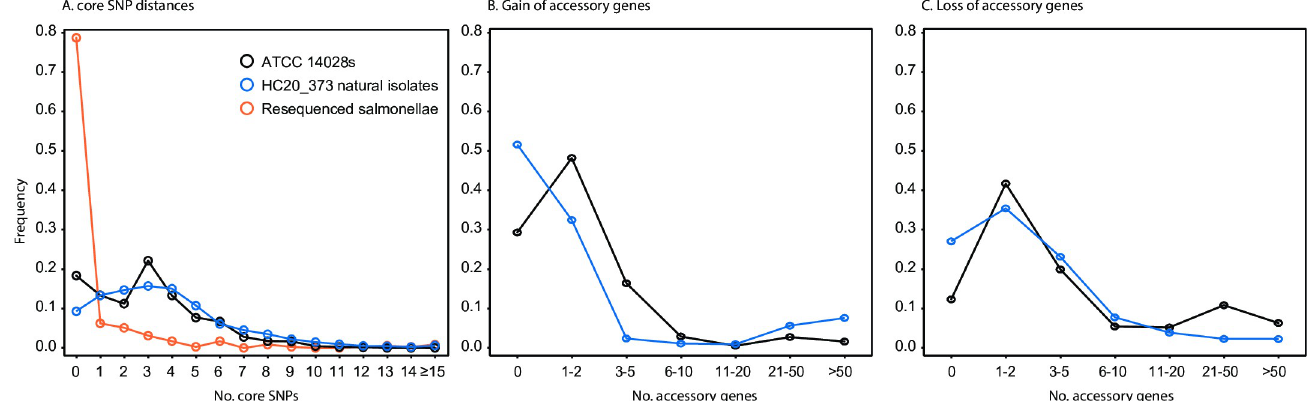
Fig 1. Core and accessory genetic diversity within 496 HC20_373 genomes from strains stored in laboratory collections or isolated from nature. A). Core SNP distances. Numbers of non-repetitive SNPs in an all against all comparison of pairs of genomes within each category. Maximum numbers of core SNP differences: Natural isolates, 30; ATCC 14028s, 16; resequenced genomes, 16. B). Numbers of additional accessory genes according to a pan-genome of all isolates in an all against all comparison of pairs of genomes within each category. C). Numbers of deleted accessory genes according to a pan-genome of all isolates in an all against all comparison of pairs of genomes within each category. ATCC 14028s (black): 172 strains from laboratory sources or from laboratory infections. HC20_373 natural isolates (blue): 324 strains from all other sources. Resequenced salmonellae (red; only in part A): 285 pairs of genomes that were sequenced twice for the UCCUoW 10K genomes project [14]. Additional details on the accessory genes in parts B and C can be found in S2 Fig.